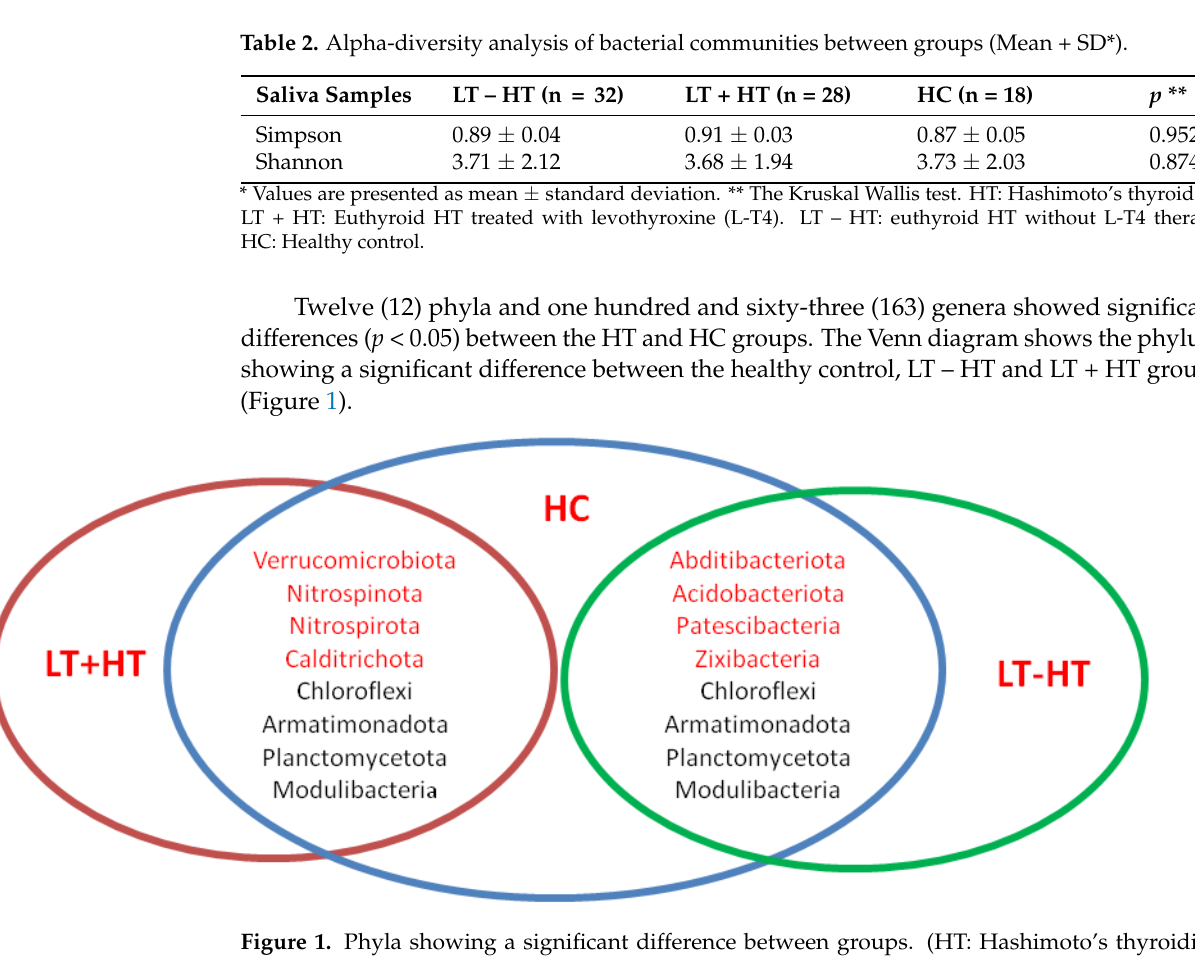
Table 2. Alpha-diversity analysis of bacterial communities between groups (Mean + SD*).